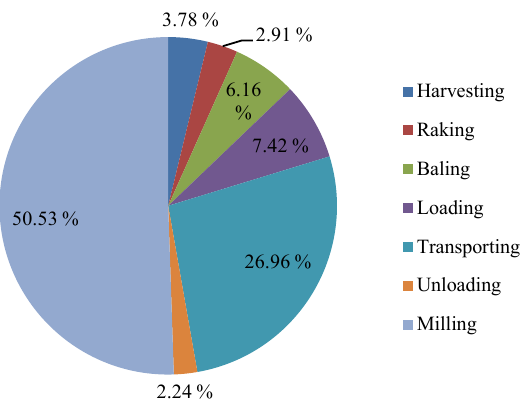
Fig. 2. The prime cost structure of biomass of grass (Technology “A”).